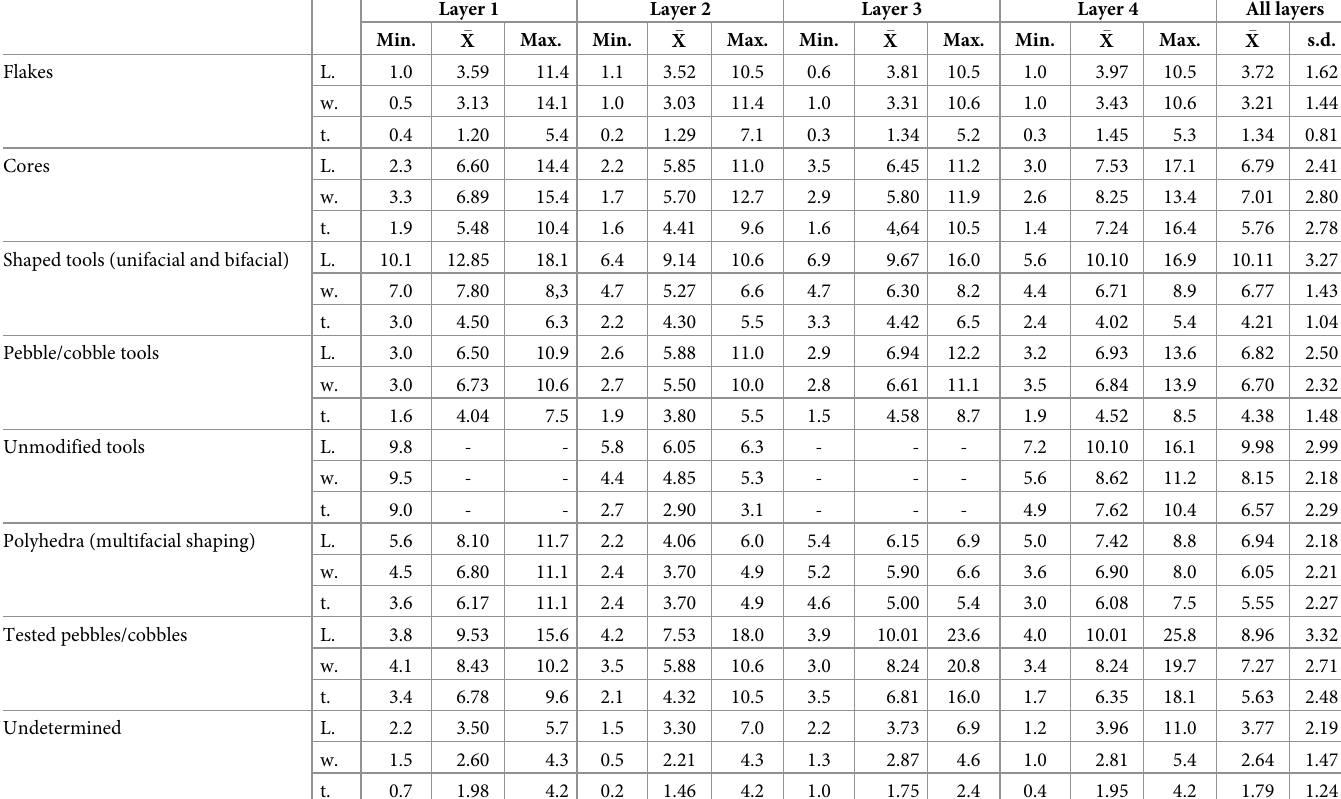
Table 2. Metric data (minimal, mean, maximal for length, width and thickness in centimeters) for each techno-typological category, per layer. Standard deviation is provided for all